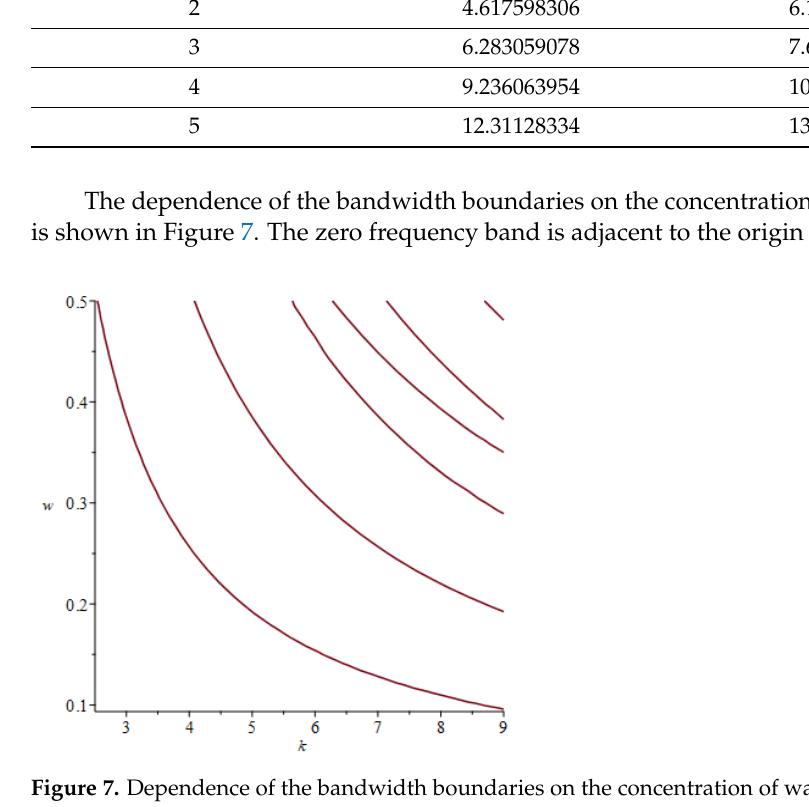
Figure 7. Dependence of the bandwidth boundaries on the concentration of water in the air. Table 3. Table of dispersion relations in the transmission frequency bands. Graphs of the Dispersion Relations for the Frequency Band Number Dimensionless Frequency and the Wavenumber for the Water Concentration in the Air Equal to 0.5 (k = 0.5)